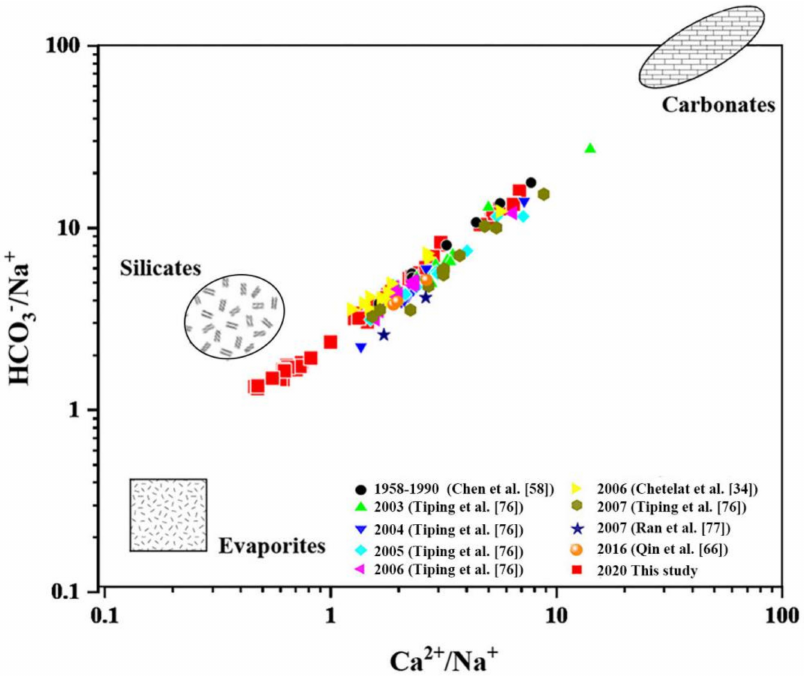
Figure 4. Using Na-normalized molar ratio in the upstream of the TGR. In Figure 5a, three red circles represent the three different end-members,